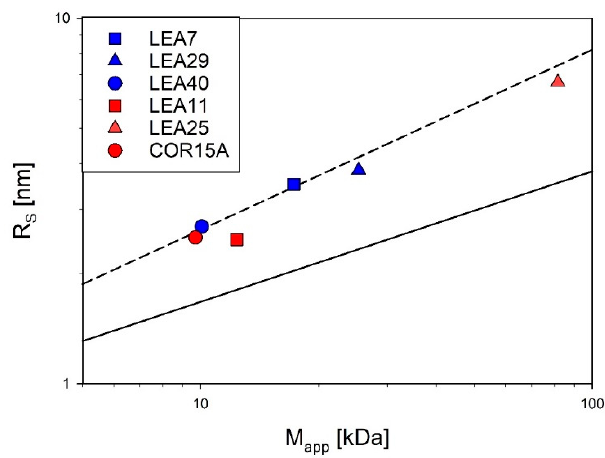
Figure 4. Compactness of the six LEA_4 family proteins visualized by using scaling laws of the type R S = a * M b . The Stokes radius (R S ) was determined by dynamic light scattering (DLS) and plotted against the molecular mass determined by static light scattering (SLS). The average compactness according to the scaling laws for compactly folded globular proteins (solid line [45]) and intrinsically disordered proteins (dashed line [46]) are shown for comparison. Data for COR15A, LEA11 and LEA25 were taken from a previous publication [30].